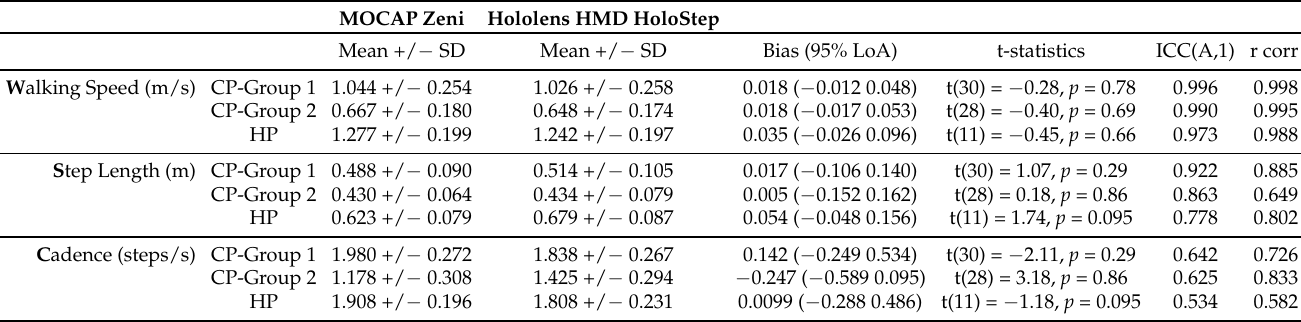
Table 3. Concurrent validity for spatiotemporal gait parameters in healthy participants (HP) and in children with cerebral palsy (Group 1 and Group